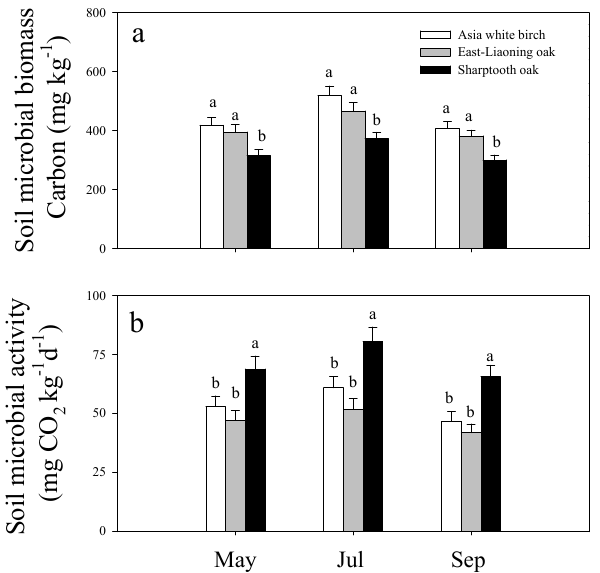
Fig. 3. Soil microbial biomass carbon and soil microbial activity in the 0–15cm mineral soil layer in Asia white birch and East- Liaoning oak forests of warm temperate zone and Sharptooth oak forest of sub-topical zone in May, July and September 2006. Ver- tical bars indicate standard errors of means ( n =5). Different letters within a month are significantly different ( P < 0.05) according to the least significant difference test.